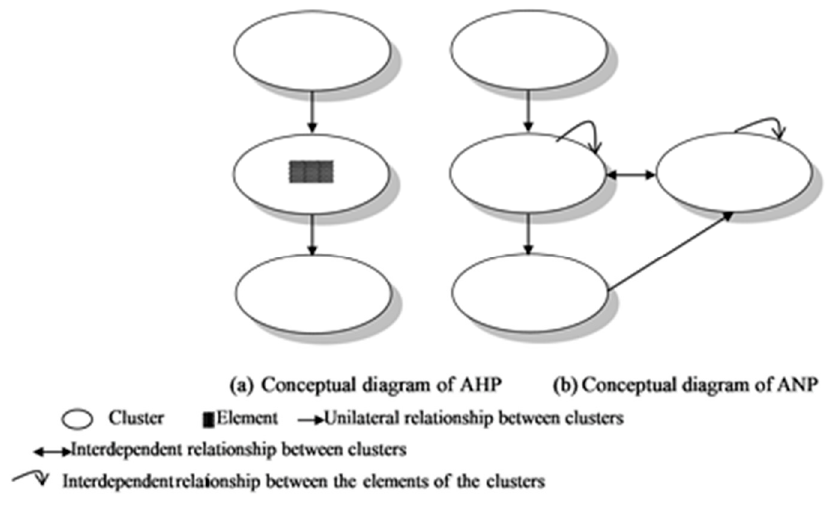
Figure 2. Conceptual diagrams of the analytical hierarchy process (AHP) and analytic network process (ANP) [22].